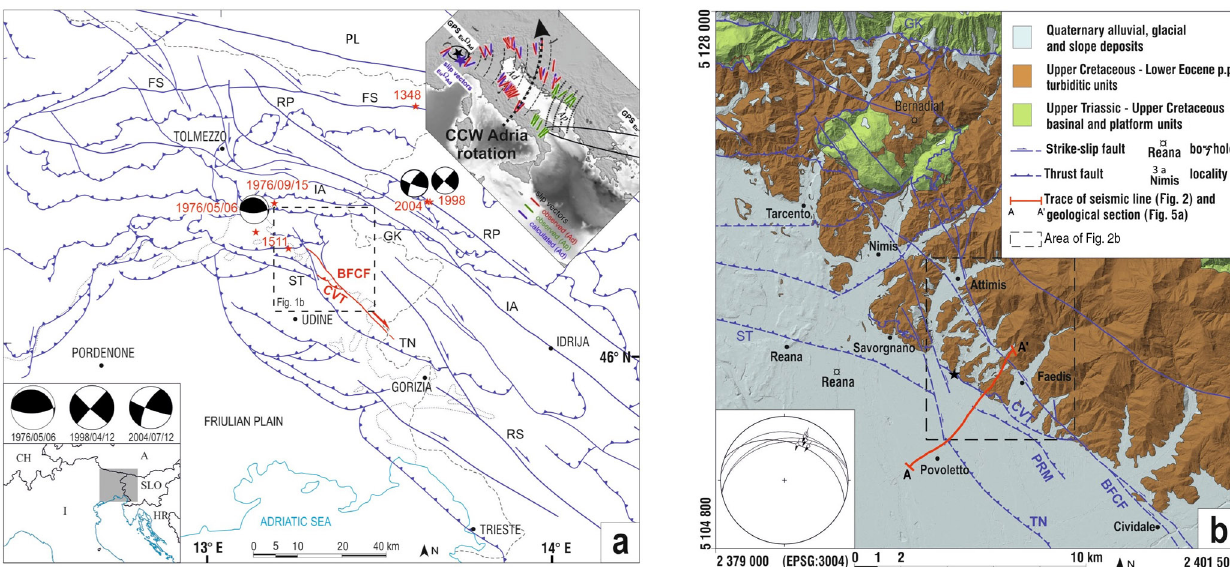
Figure 1. (a) Tectonic map of the eastern Southern Alps and western Dinarides (modified from Zanferrari et al., 2013). Adria counter- clockwise rotation (D’Agostino et al., 2008), inset; BFCF: Borgo Faris–Cividale fault; CVT: Colle Villano thrust; GK: Gemona–Kobarid thrust; IA: Idrija–Ampezzo fault; PL: Periadriatic lineament; RP: Ravne–Paularo fault; RS: Raša fault; ST: Susans–Tricesimo thrust; TN: Trnovo nappe thrust front (Placer et al., 2010). Red stars: epicenters of the strongest historical and instrumental earthquakes (Rovida et al., 2016) and the related focal plane solutions. Italian boundary, thin dashed line. Hills–plain boundary, dotted lines. (b) Geological map of the study area (modified from Carulli, 2006; Zanferrari et al., 2008a, 2013). PRM: Premariacco thrust. Paleoseimological trench site, black star. Stereographic projection (lower hemisphere) of calcite slickenlines collected on the CVT,